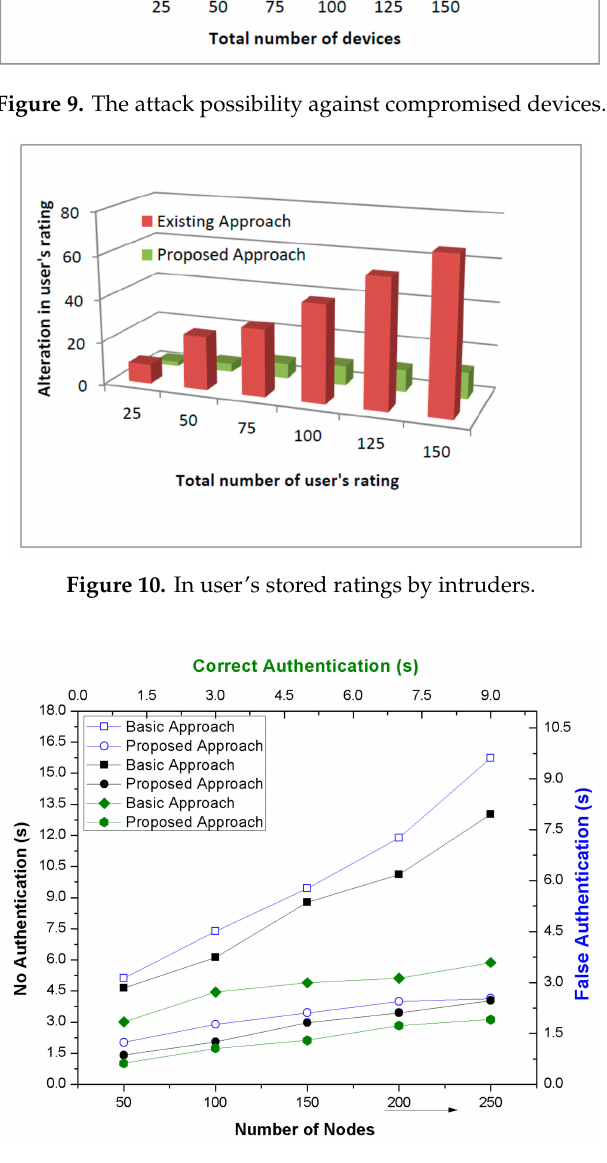
Figure 11. Probabilistic scenarios of attack